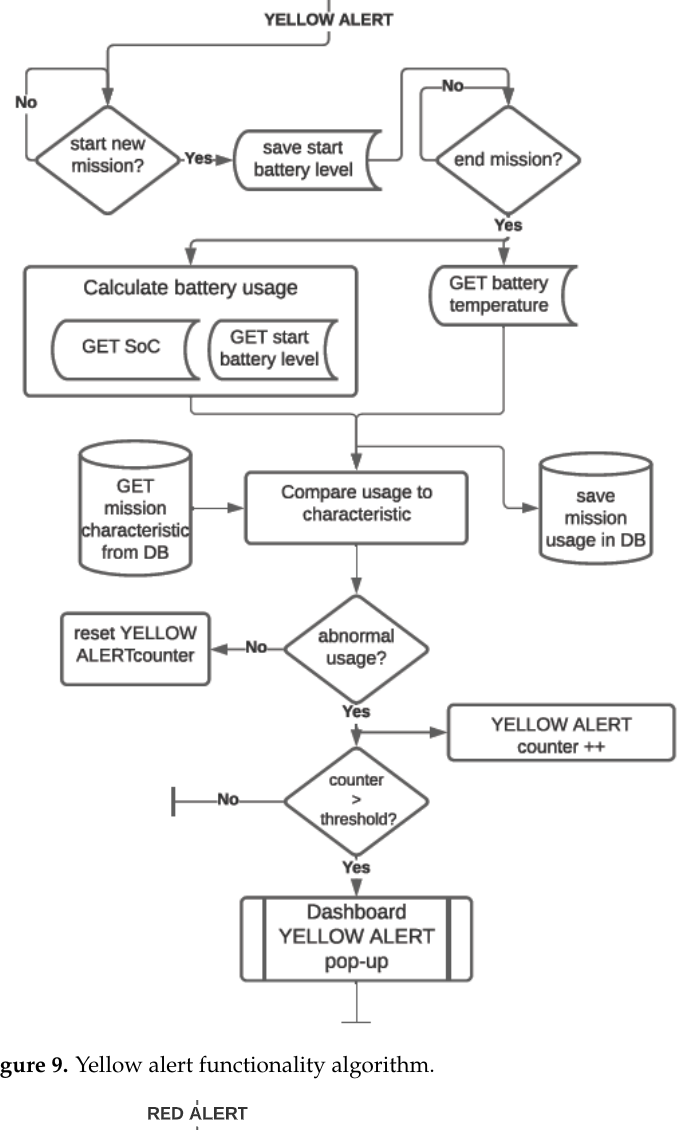
Figure 9. Yellow alert functionality algorithm.